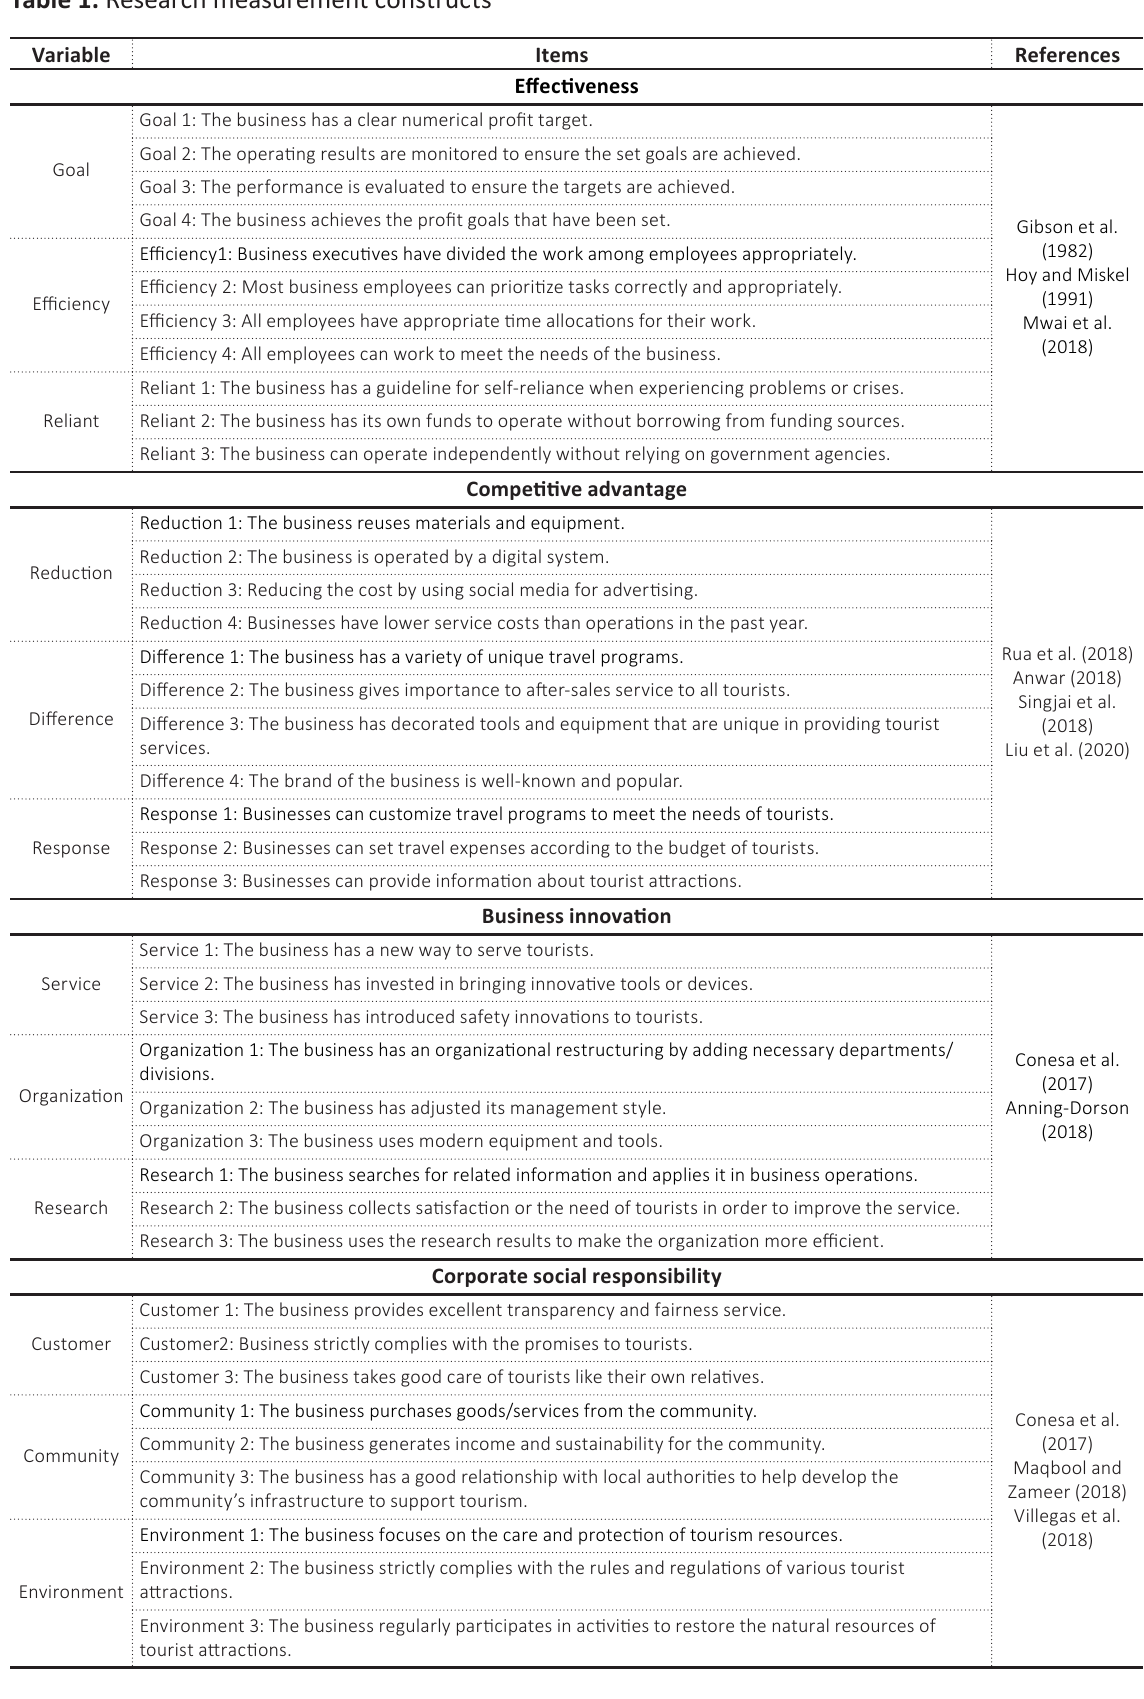
Table 1. Research measurement